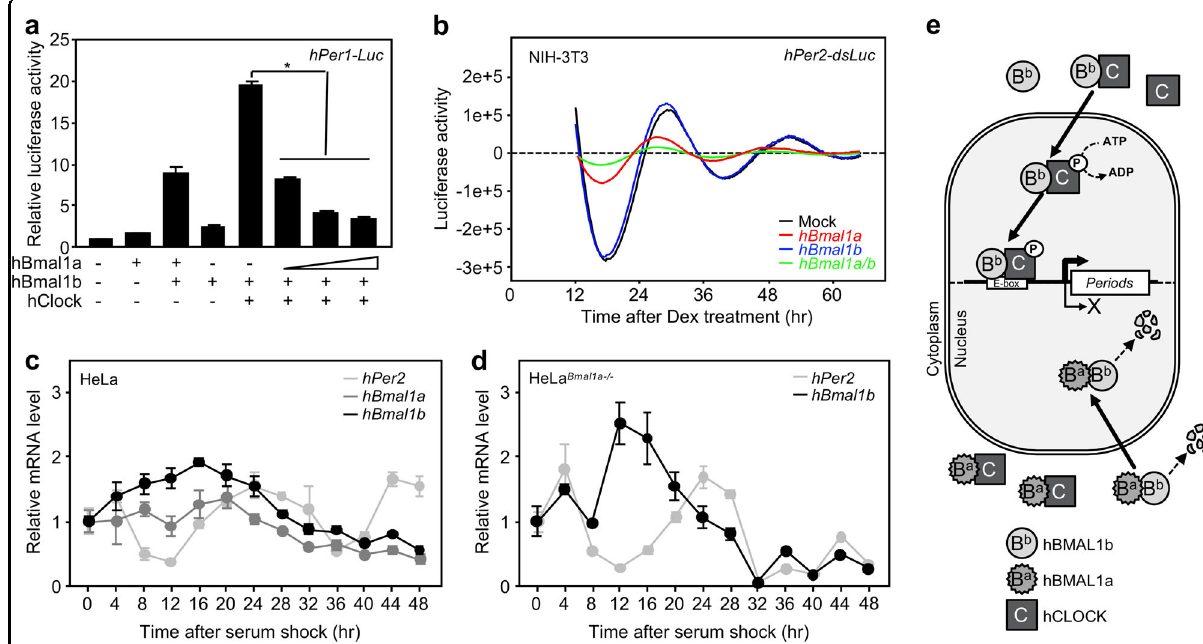
Fig. 5 Dominant-negative effect of hBMAL1a on the regulation of the molecular circadian clock. a The activation of hPer1 promoter linked to fi re fl y luciferase was assayed in HEK293T cells transfected with the indicated plasmid DNAs. The relative luciferase activities are shown as the means ± standard errors (S.E.) (* P < 0.01). b The effect of hBMAL1a and/or hBMAL1b on the rhythmic expression pro fi le of the hPer2 promoter linked to destabilized fi re fl y luciferase ( dsLuc ) was measured in NIH-3T3 cells for 72 h using Kronos-Dio (Atto). c , d Circadian expression levels of hBmal1a , hBmal1b , and hPer2 mRNAs in HeLa or HeLa Bmal1a − / − cells were analyzed. Following the application of 50% horse serum for 2 h, relative mRNA levels were determined by qPCR for 48 h. e A model for the dominant-negative function of hBMAL1a. In the cytoplasm, hBMAL1a interferes with the formation of hCLOCK:hBMAL1b heterodimer complex by binding hCLOCK or hBMAL1b proteins. Through this direct interaction, hBMAL1a prevents hCLOCK phosphorylation and nuclear translocation, which are closely related to the transcriptional activity of hCLOCK. The hBMAL1a protein also promotes the proteolysis of hBMAL1b through a direct interaction. Consequently, hBMAL1a functions as a dominant-negative regulator in